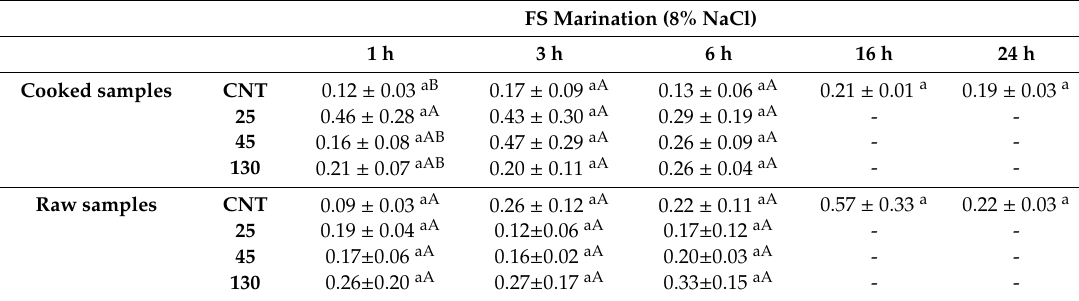
Table 4. TBARS values; Chicken breast samples were marinated using power ultrasound operating with a frequency of 25, 45 or 130 kHz for 1, 3 or 6 h. Values for a chicken sample marinated without ultrasound (CNT) are also presented. Values represent means ± standard deviation (SD, N = 4). TBARS values are expressed as µ g MDA / g of meat on cooked and raw